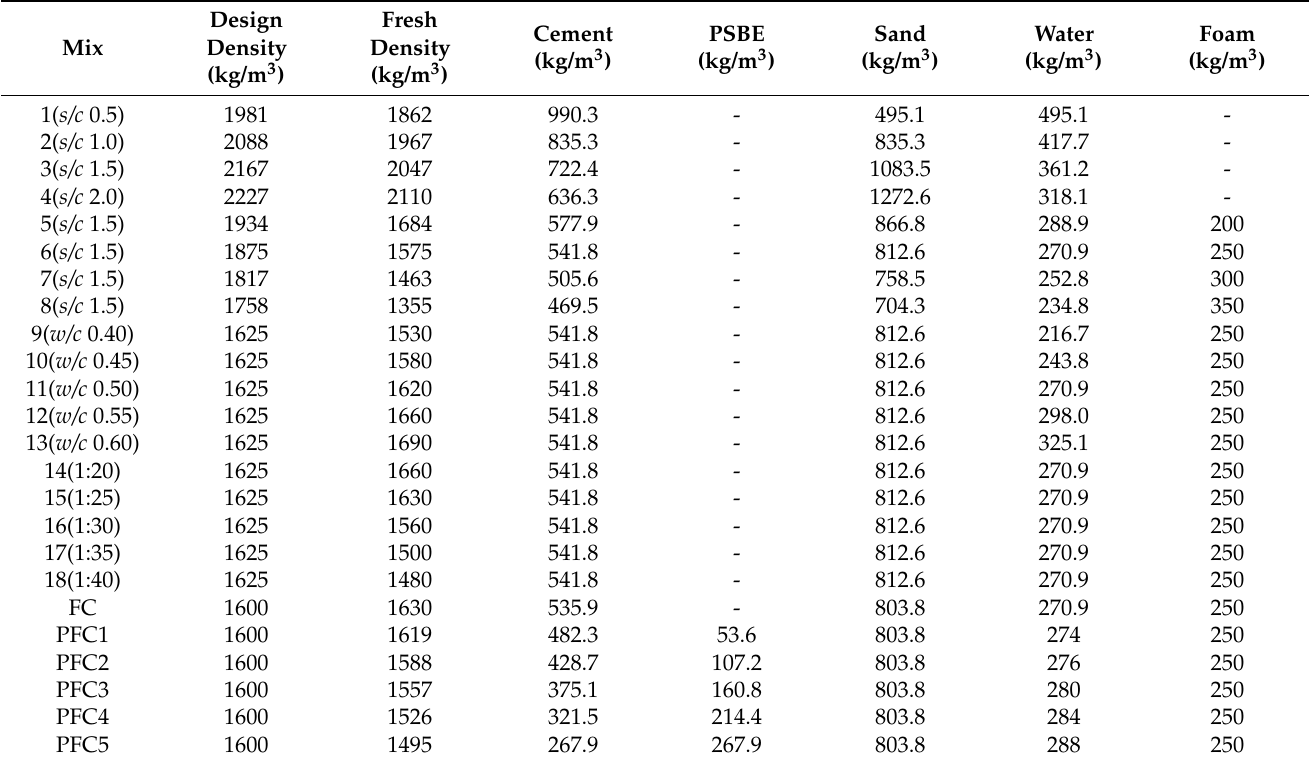
Table 2. Mix proportion and densities of foamed